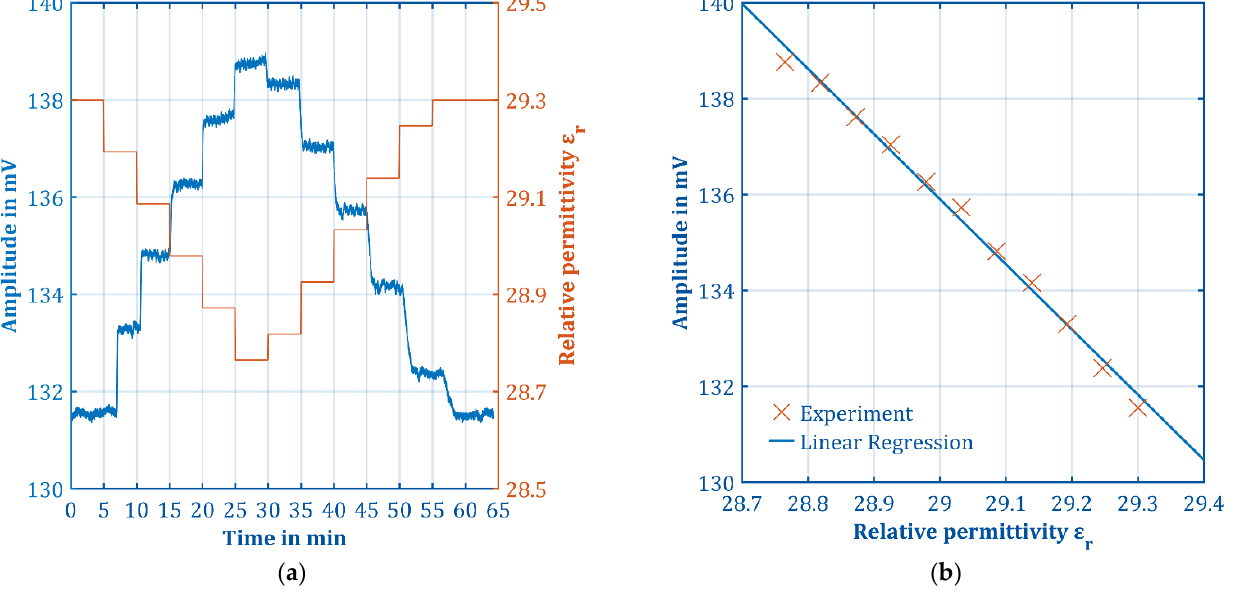
Figure 11. ( a ) Continuous measurement (capillary split ring resonator with new readout electronics) of 2-propanol (0% to 5%) in ultrapure water, giving relative permittivities from ε r = 29.3 to ε r = 28.77 ( b ) Mean value (orange cross) of the output signal of each relative permittivity step and linear regression (parameters given in Equation (6)) with an R 2 of